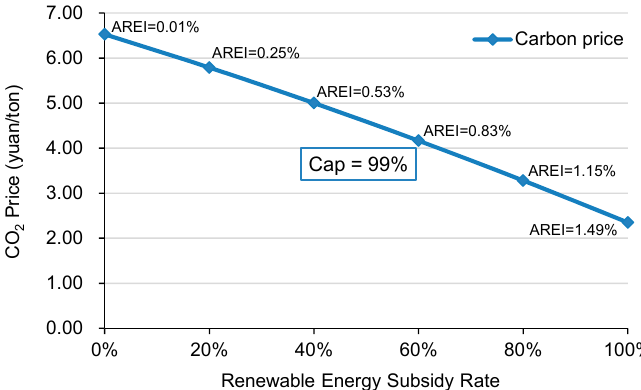
Figure 5. CO 2 price changes under different RES subsidy rate. (AREI denotes annual renewable energy ratio increase).